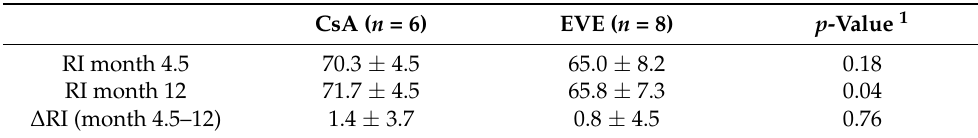
Table 6. Mean resistive indices measured by duplex ultrasound according to medication group and time-point.